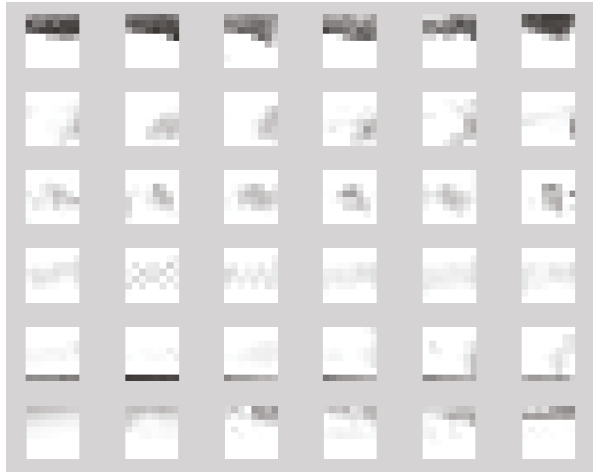
Figure 6: Some of the similar pattern blocks (6 similar pattern blocks from left to right in each